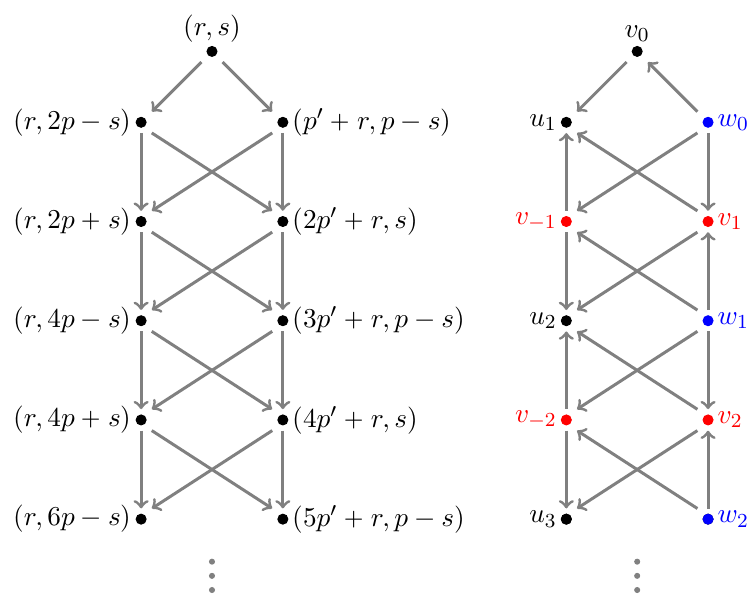
Figure 5 . Verma module structure versus Fock space